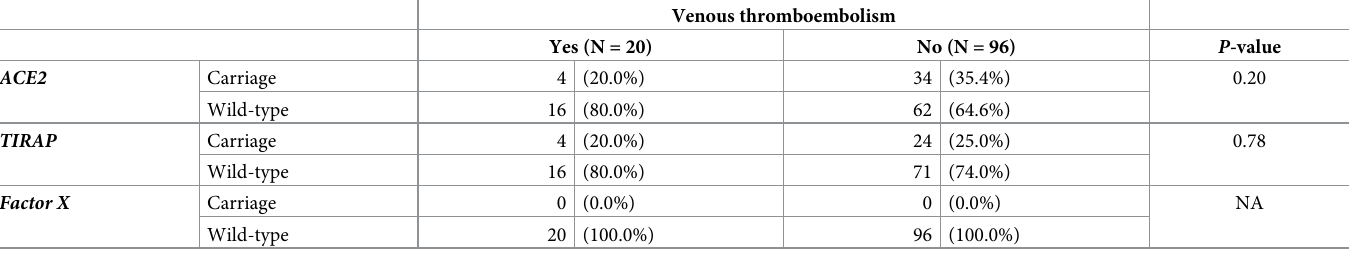
Table 5. Genotype frequencies in patients with and without venous thromboembolism.